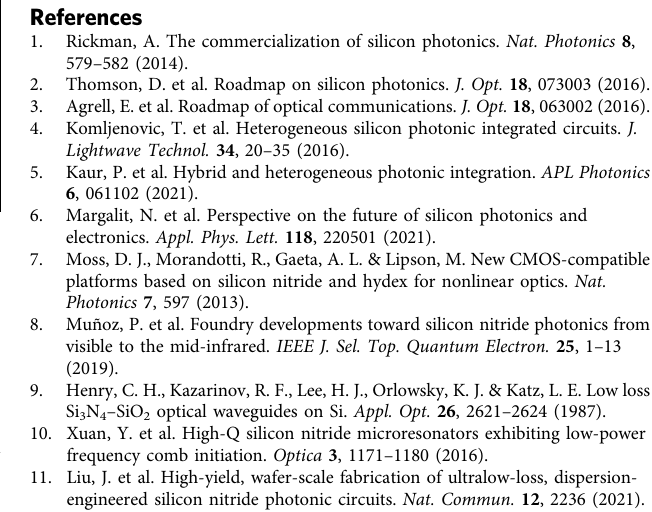
Table 1 FDTD simulation results for transmitted power distribution in selected waveguide eigenmodes, for d = 60 μ m circular bend ( p = 0), partial Euler bend ( p = 0.6) and Euler bend ( p = 1). The optical fi eld distributions in these three bends are shown in Fig.